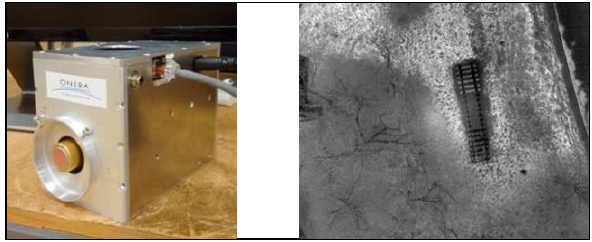
Figure 6. Infrared camera for UAS SOIE (left), and airborne image of a piece of railroad from a rotating wings UAS (right) Three infrared cameras will be used on UAS. First one, SOIE is a 3-5 µm cryogenic camera, jointly developed by SOFRADIR and ONERA, which constitutes a part of the in-kind investment of SOFRADIR in TERRISCOPE. The cold meniscus of the camera has been replaced by a plano-convex Fresnel lens, decreasing the optical thermal mass of 66% (Druart, 2016).